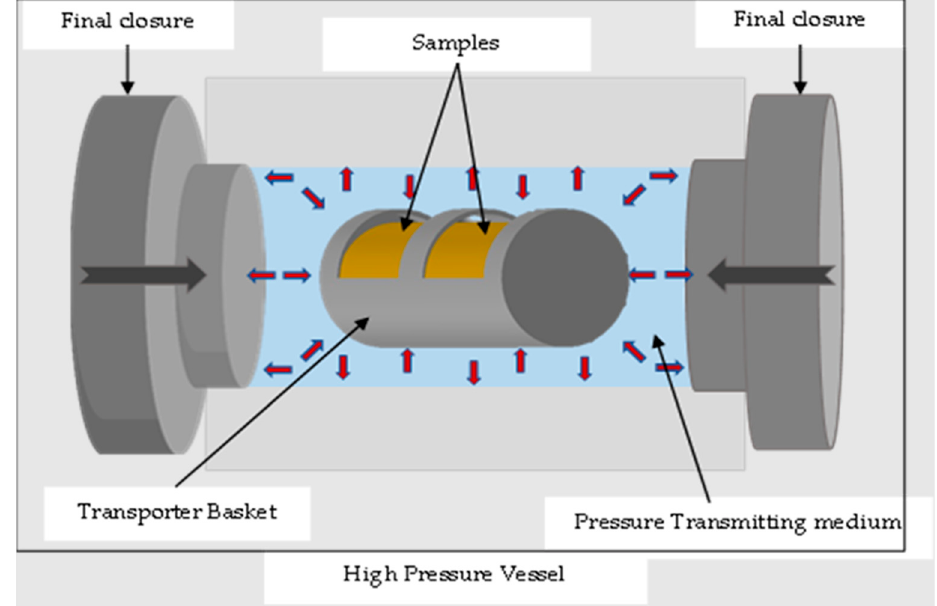
Figure 5. Schematic representation of an HPP unit. Adapted from [114]. HPP and high-pressure homogenization (HPH) are two separate techniques that fall under the category of HPP [66]. With pressures ranging from 100 to 600 MPa and time ranging from 3 to 30 min, HPP is a batch process based on the Le Chatelier principle that has already been employed in several food industrial sectors. Pre-packaged products are placed inside the pressure chamber and compressed for the designated amount of